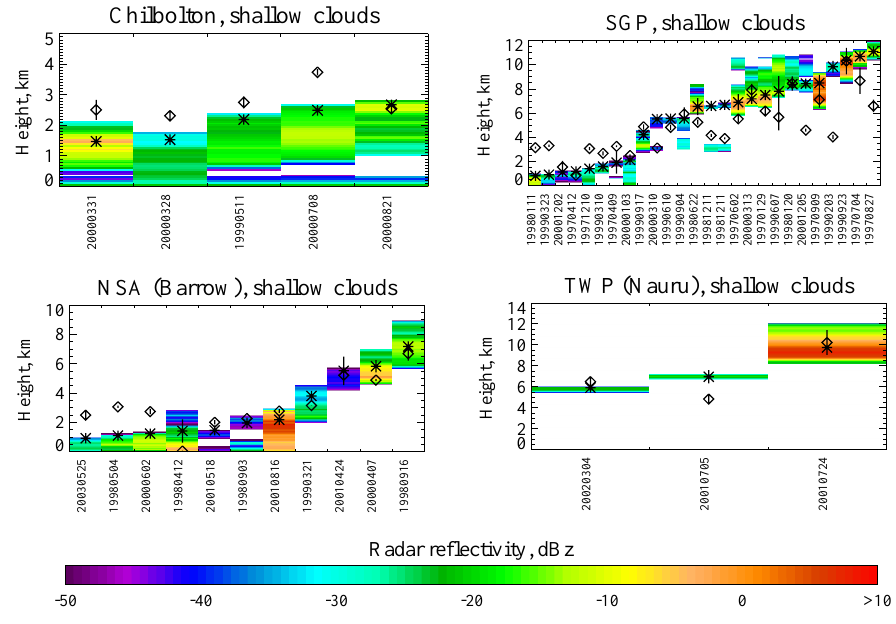
Fig. 9. Comparison between ground-based and ATSR-2 CTH for shallow cloud fields, using the definitions presented in the text. Clockwise from top-left, the sites are Chilbolton, SGP, NSA and TWP. The comparisons are ordered in ascending ground-based effective IR-radiating height, with the date of each coincidence noted below the plot. For each comparison, the coloured area indicates the radar reflectivity profile for the coincidence, and the black star the estimated effective IR-radiating ground-based CTH and its uncertainty. Diamonds with error bars show the ATSR-2